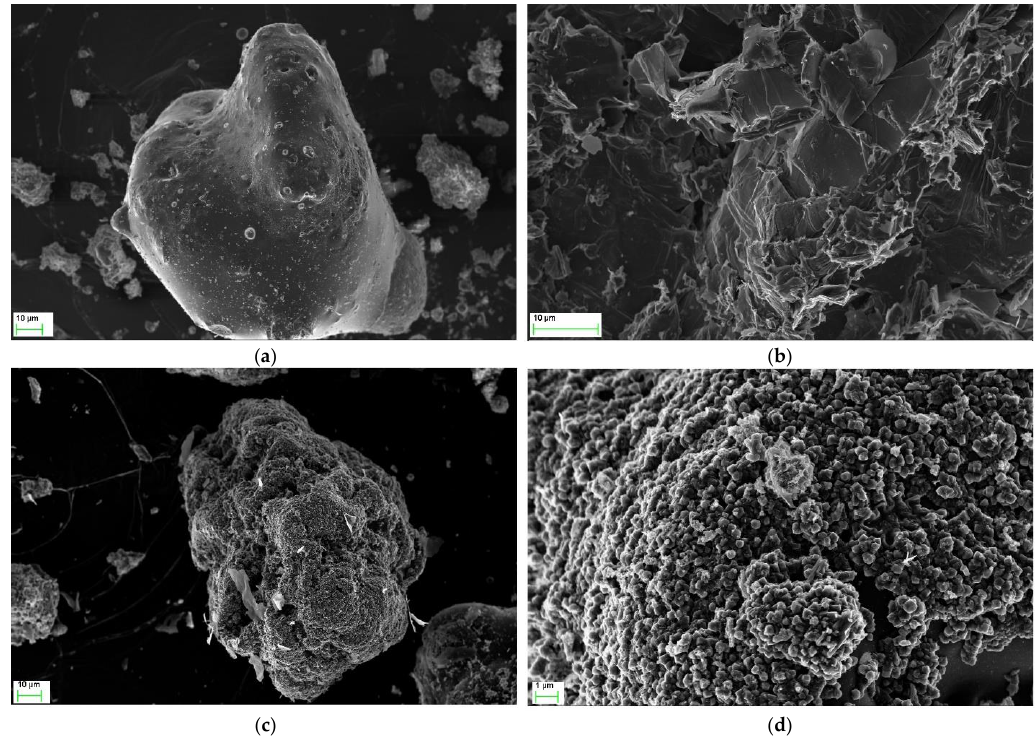
Figure 3. Representative SEM pictures of the ( a , b ) starting material, ( c ) concentrated CO 2 carbonated materials at 7 bars over 4 h and ( d ) close-up of Figure 3c, showing rhombohedral calcite crystals. Additional insights on the progress of the carbonation reaction can be gained from TPD analysis. Figure 4 exhibits the derivative weight changes as a function of temperature in the range of 30 – 850 °C. Untreated samples of fly ash are characterized by only one stage of mass loss, starting at 600 °C, that corresponds to precursor carbonates in the fly ash due to natural carbonation. In the treated samples, three different mass loss stages can be identified. The first one, starting at 400 °C, can be attributed to portlandite decomposition, which was created during the hydration of original CaO [47]. The formation of portlandite could affect the final carbonation efficiency, as the Ca in lime is fixed by hydration in portlandite and by carbonation in calcite. At higher temperatures, carbonate decomposition can occur in the range from 600 to 650 °C, leading to a much higher mass loss when compared with the untreated fly ash. The subsequent stage observed at T > 650 °C (illustrated by the positive slope of the TPD curve) indicates that further decomposition of more thermally stable carbonates continues beyond the studied temperature range, in agreement with Cwik et al., 2018 [28], due to differences in particle size and/or the presence of amorphous calcium carbonate, known to decompose at higher temperatures [48,49].